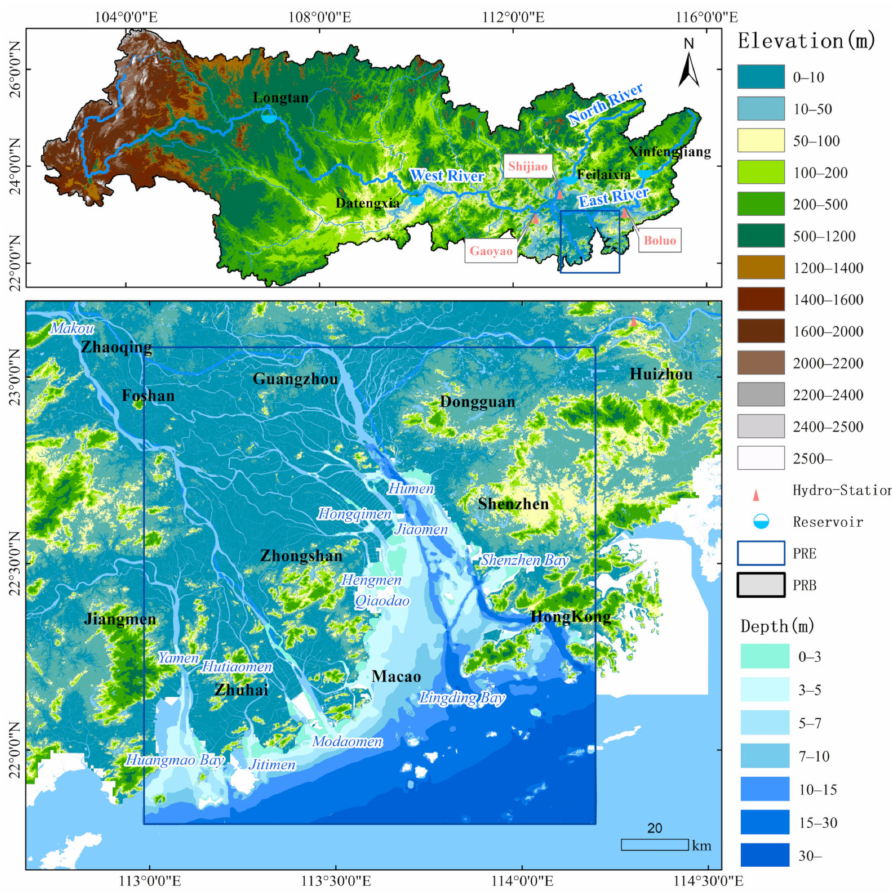
Figure 1. Geographical map of main streams of the Pearl River and spatial configuration of